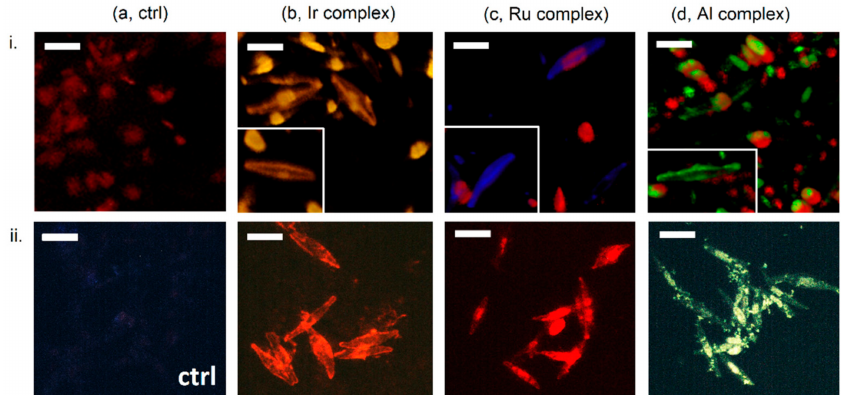
Figure 5. ( i ) 3D-confocal reconstruction images of living diatoms ( a : bare, b : Ir-doped, c : Ru-doped, d : Al-doped cells); ( ii ) bidimensional fluorescence microscopy images of bare and doped frustules after acid-oxidative treatment. Scale bar 10 µ m.